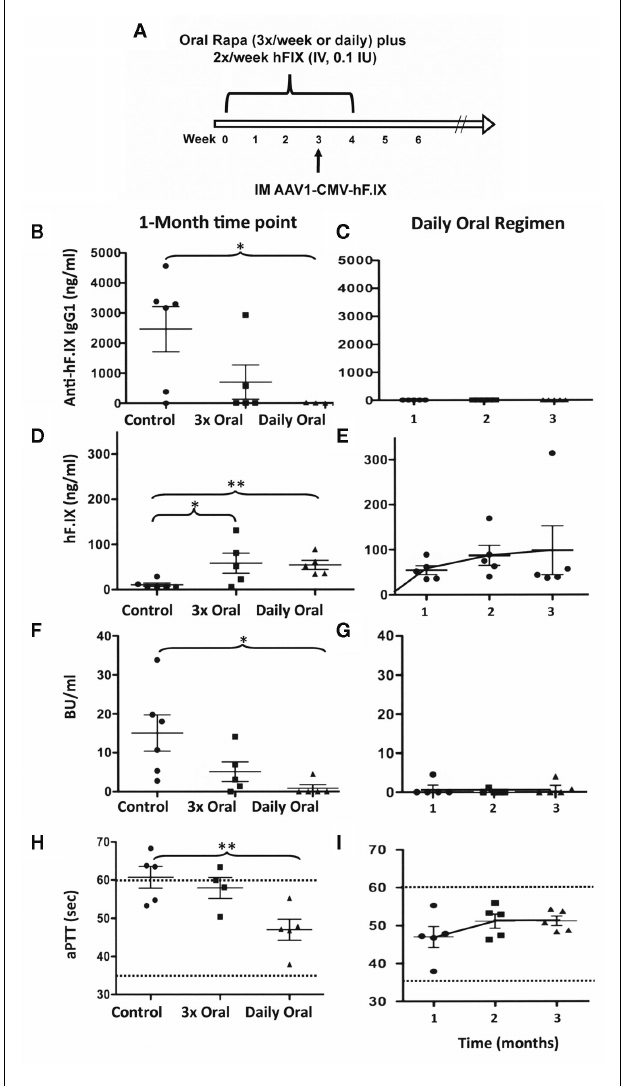
FIGURE 2 | Optimization of a protocol that prevents inhibitor formation by administration of hF.IX protein and rapamycin. (A) Experimental timeline of the optimal protocol. For immune modulation, C3H/HeJ F9 − / − mice received hF.IX IV injections (0.1IU/dose) twice per week for 4weeks. During that time, rapamycin was administered orally once per day. One week before the end of this 1-month regimen, AAV1-CMV-hF.IX (1 × 10 11 vg/mouse) was given IM. Left panels: Comparison of IgG1 (B) and inhibitor (F) formation against hF.IX, of systemic hF.IX expression (D) , and of coagulation times [aPTT (H) ] at 1month after vector administration in mice that had received vector only; or 2 IV doses of hF.IX (0.1IU) plus 3 oral doses of rapamycin per week (with the first and last 30min prior to hF.IX administration); or the optimal protocol (2 IV doses of F.IX plus daily rapamycin). Right panels: IgG1 (C) and inhibitor (G) formation against hF.IX, systemic hF.IX expression (E) , and coagulation times [aPTT (I) ] as a function of time after vector administration in mice that had received the optimal protocol (2 IV doses of F.IX plus daily